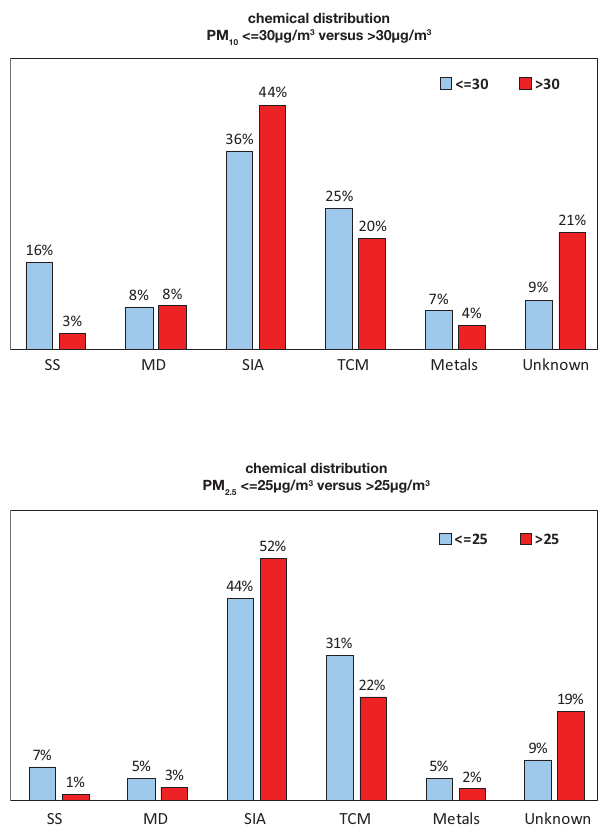
Fig. 5. Average chemical distributions in data subsets with high and low PM concentrations. Above: PM 10 > 30µg m − 3 vs. m − 3 . Averages over the five BOP